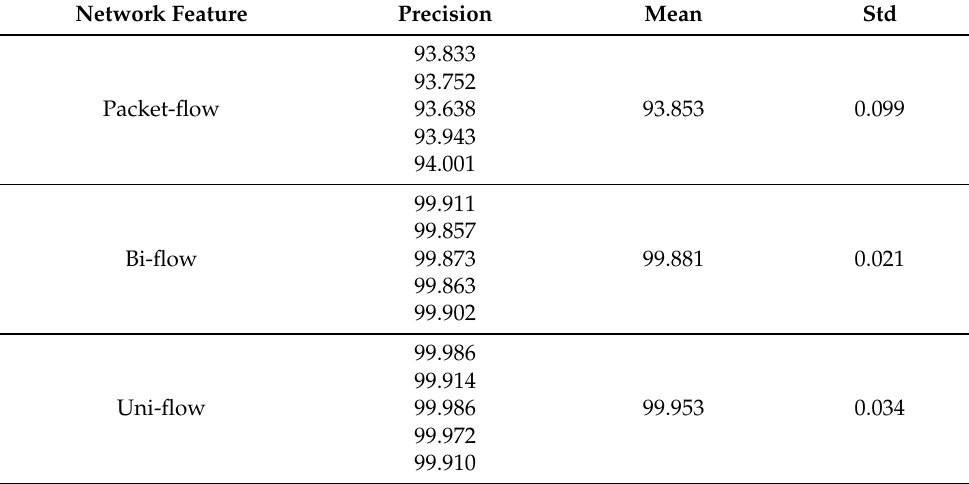
Table 11. Binary-class attack classification results in terms of precision.